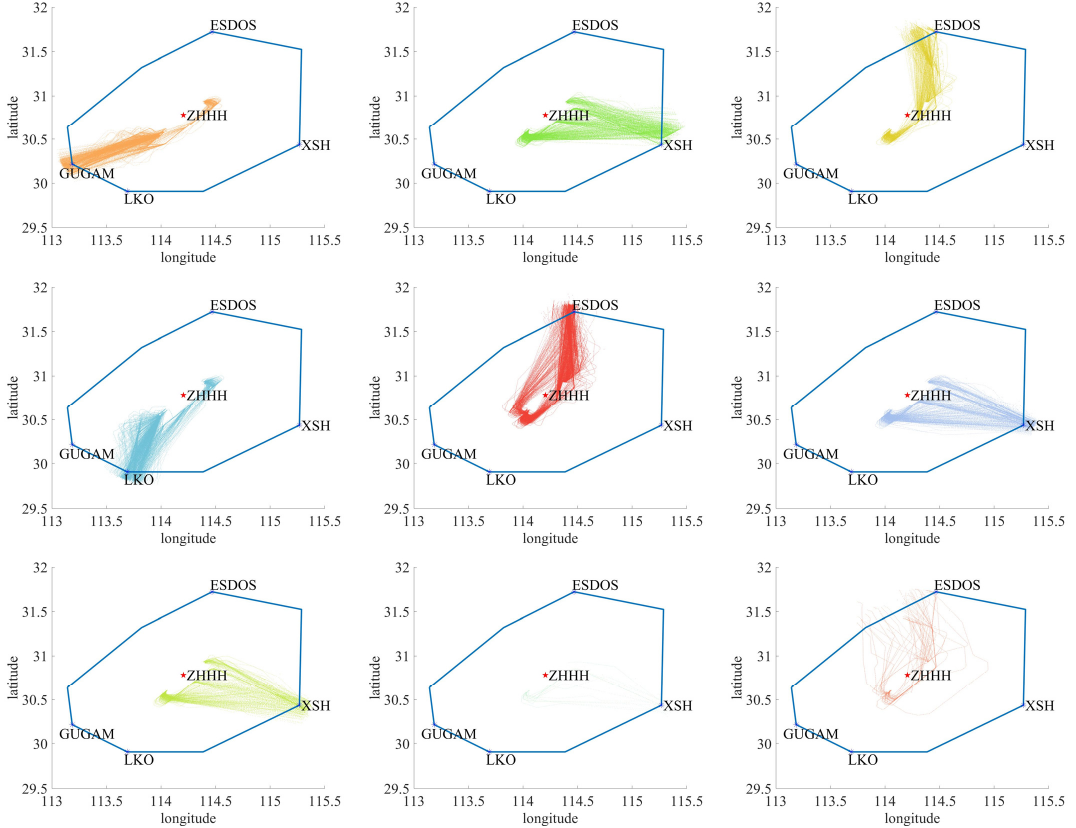
Figure 12. Clustering results of flight trajectories of ZGGG (DBSCAN).